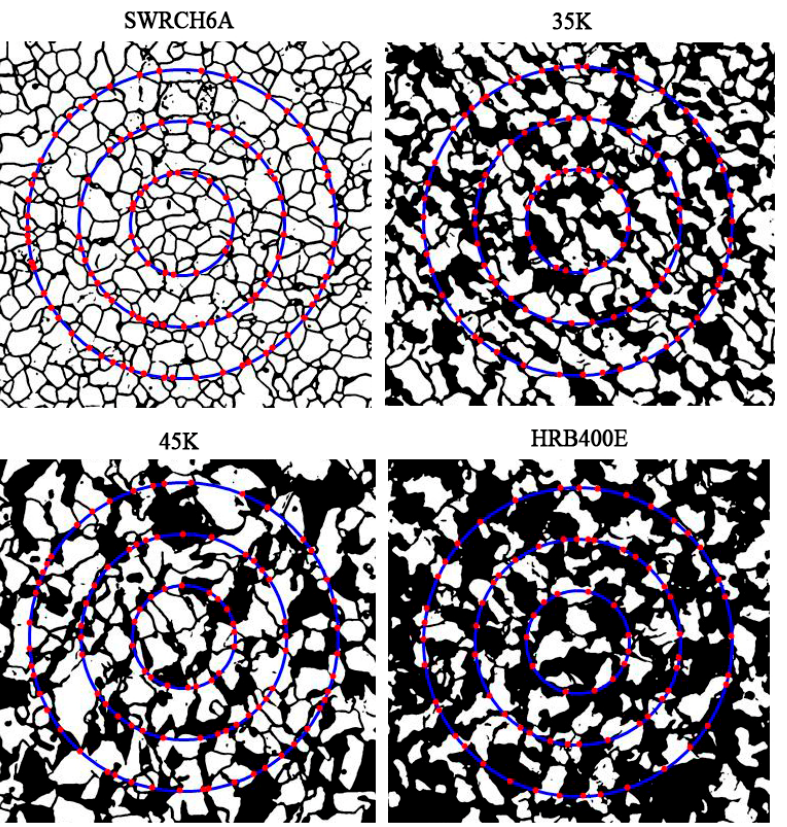
Figure 11. Processing results of four types of steels.